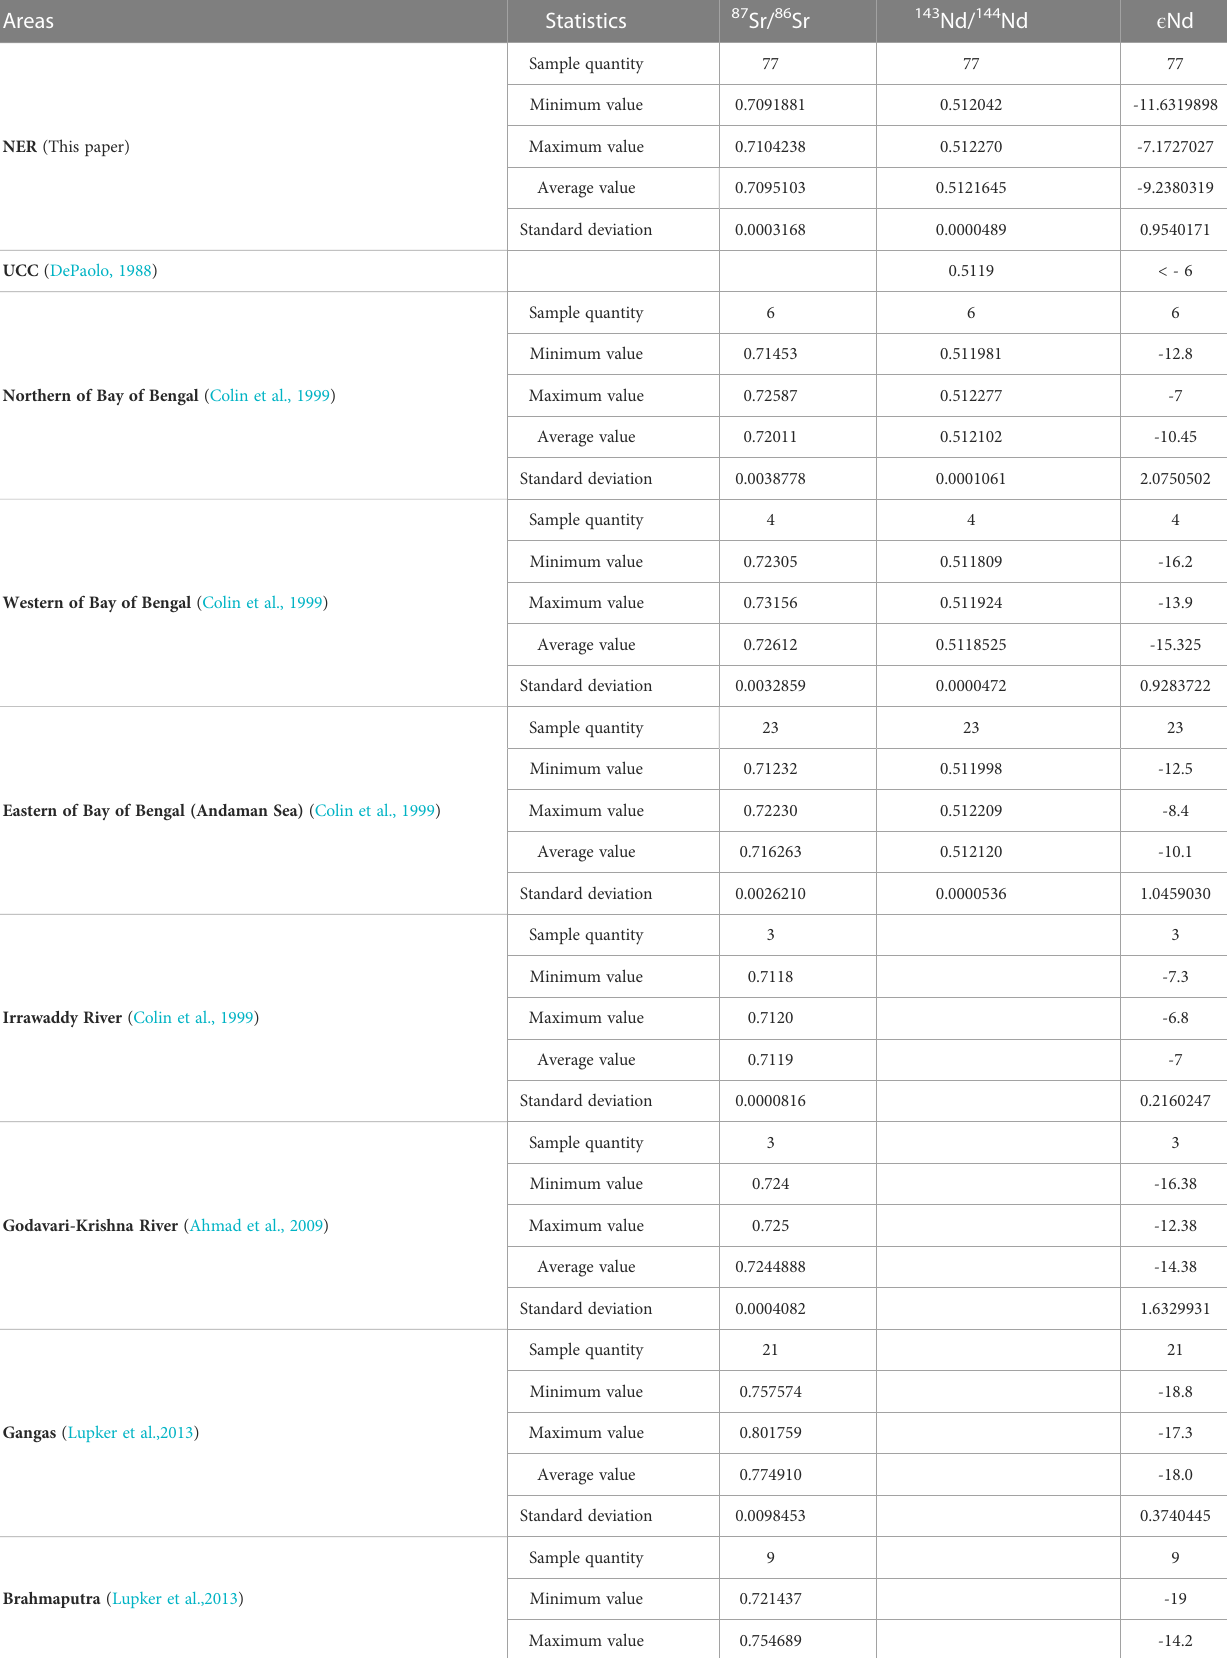
TABLE 1 Summary statistics for Sr-Nd isotope ratios of surface samples of the northern NER and compared adjacent